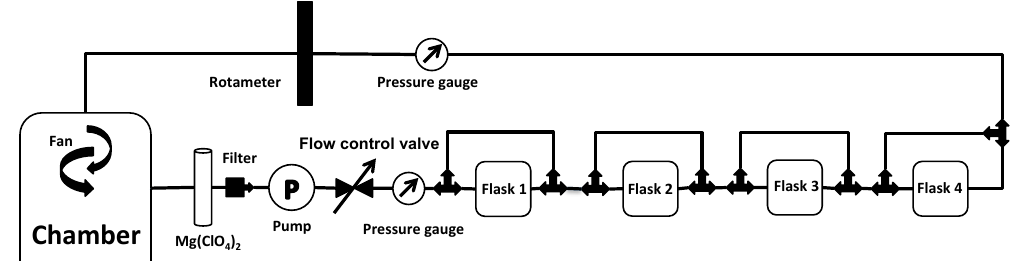
Figure 2. Scheme of the sampling setup using the closed-cycle air sampler. The volume of the soil chamber was 22.8L and the volume of each flask was